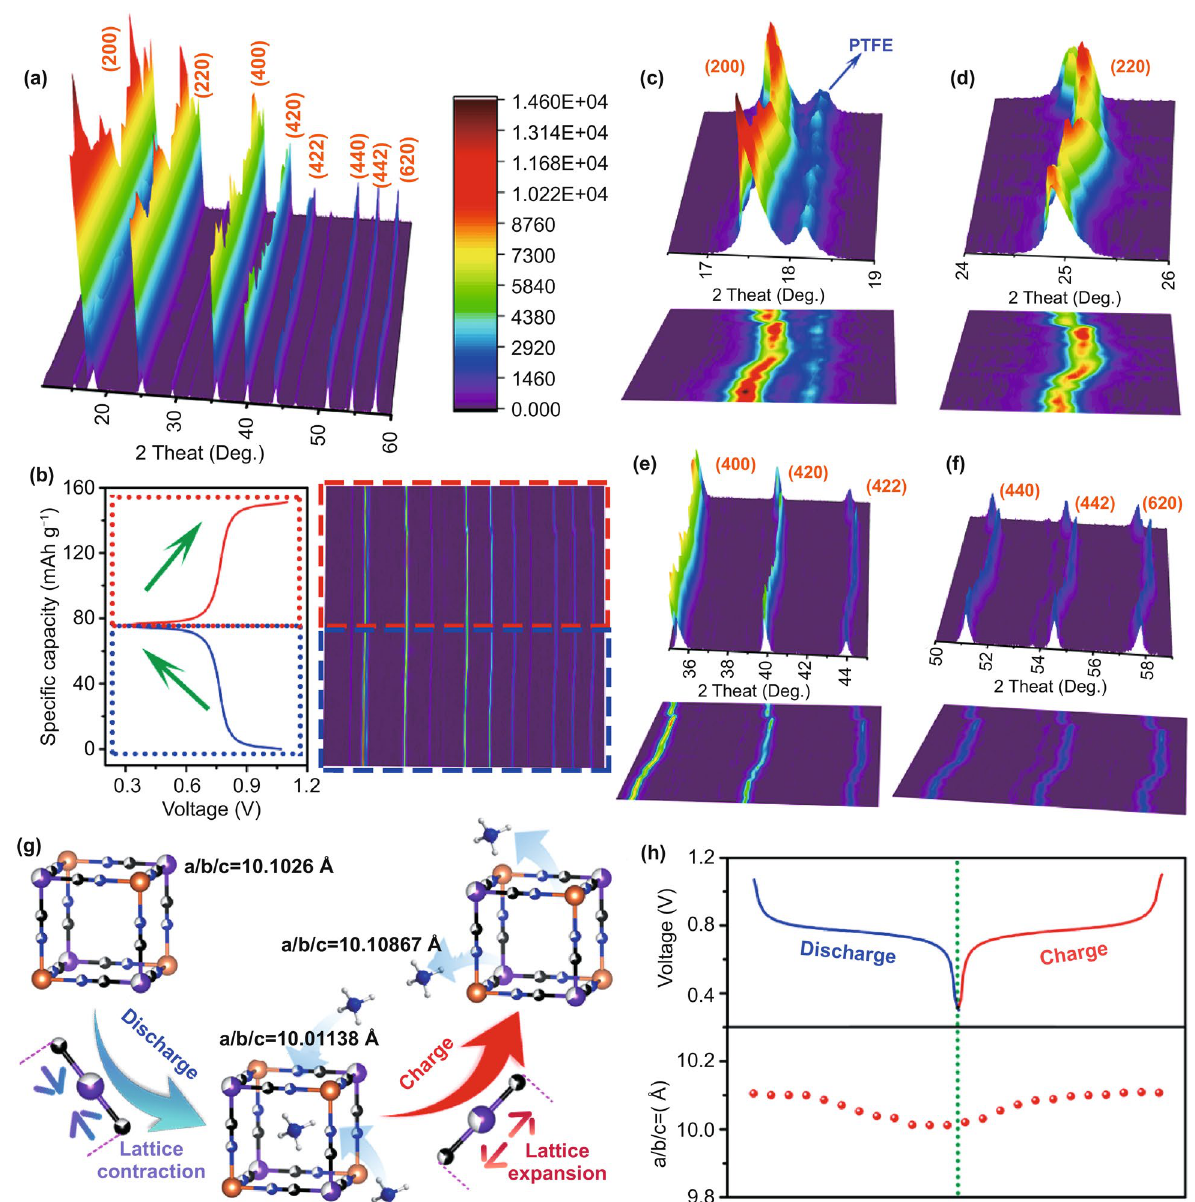
Fig. 5 a Overall XRD patterns and the two-dimensional color map. b Corresponding GCD curves and projection view of XRD patterns. c–f Enlarged regions of 16°–19°, 23°–27°, 35°–45°, and 50°–60°. g Schematic illustration of the changes in Fe–C bond distance during ammonia- tion/de-ammoniation progresses. h Lattice parameter changes during charge/discharge